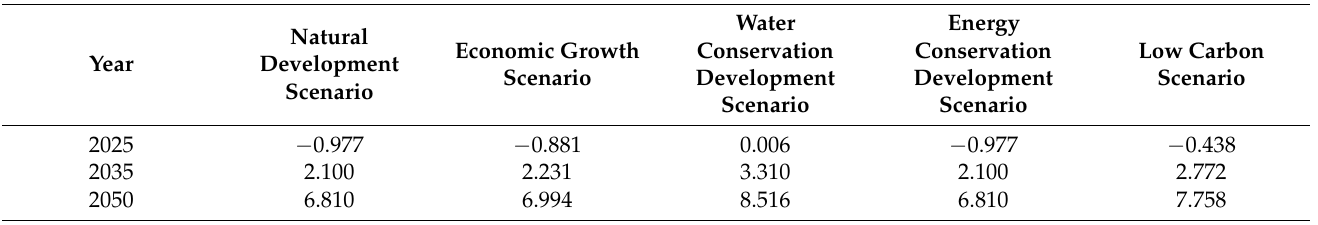
Table 4. Metabolic trends of the main water and energy variables for Hebei under the five scenarios from 2020–2050. Gap of Water Supply and Demand (Unit: Billion Cubic